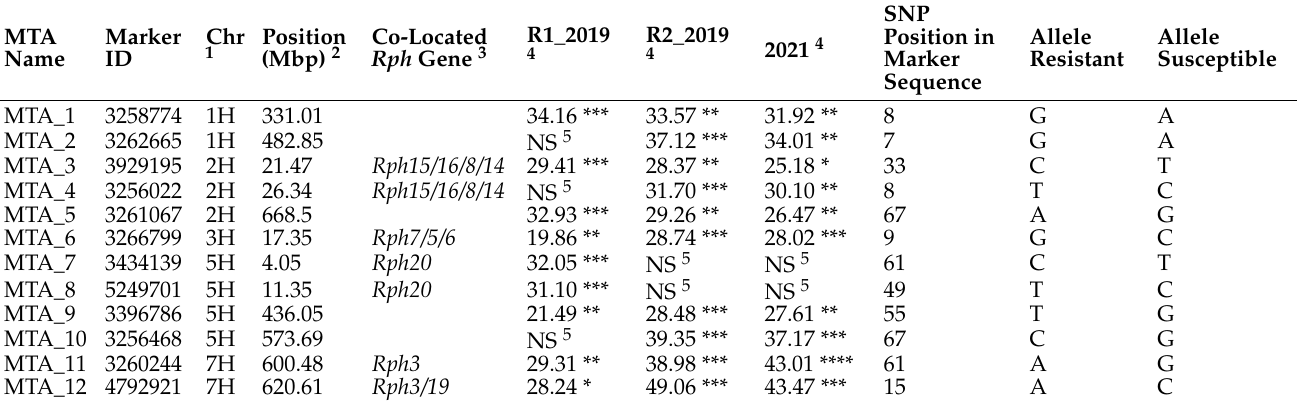
Table 1. Summary of the marker–trait associations (MTAs) detected at three time points (R1_2019, R2_2019 and 2021) at adult-plant stage in field.